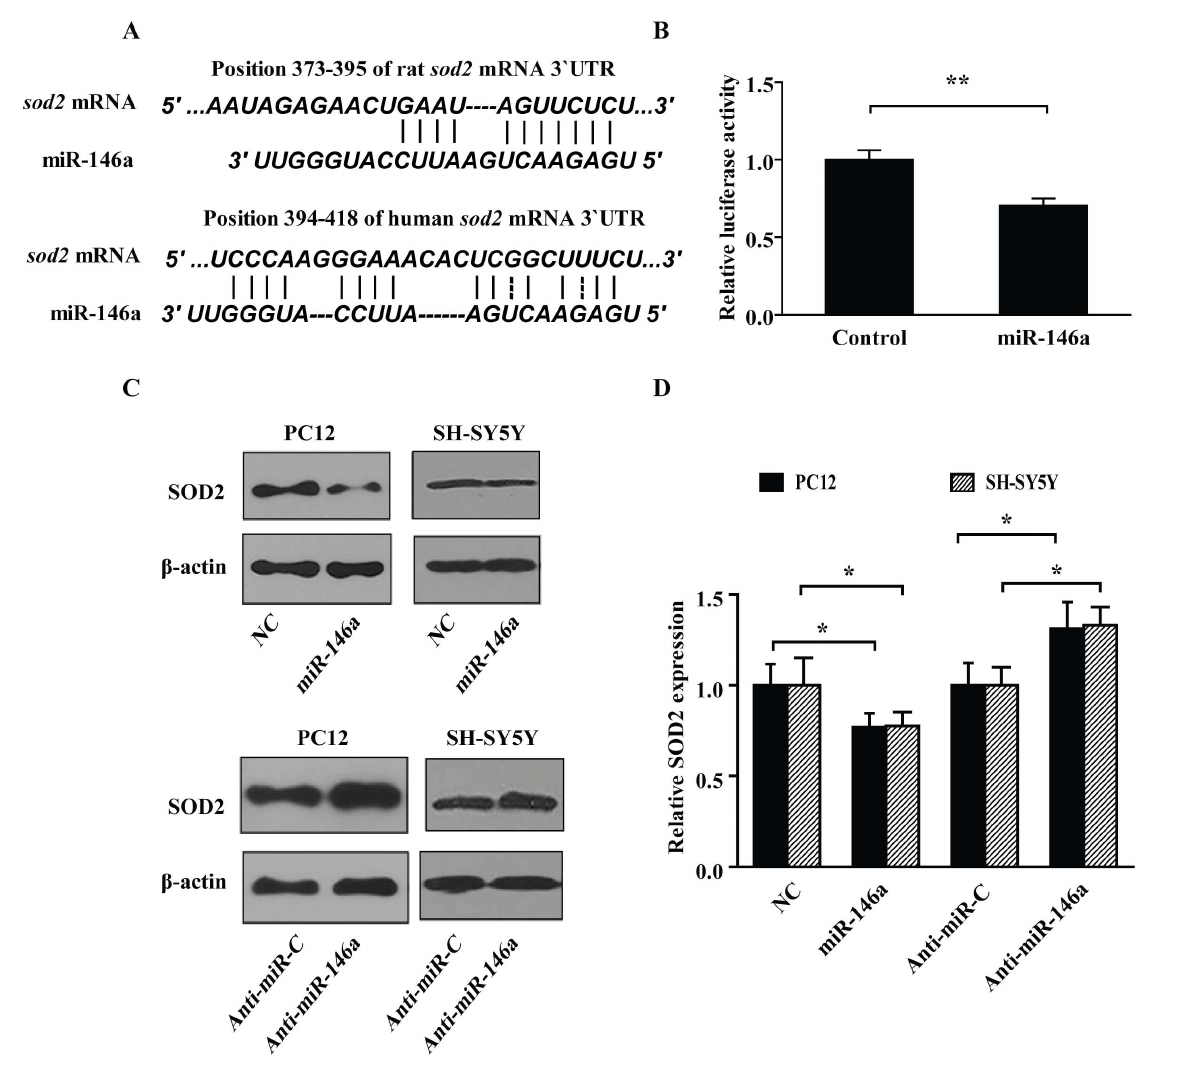
Figure 3. SOD2 was identified as a target of miR-146a in PC12 and SH-SY5Y cells. (A) Prediction of the interaction between sod2 mRNA 3 9 UTR and miR-146a. Sequence analysis showed that rat sod2 mRNA 3 9 UTR 388-394 position mated with the rat miR-146a 2-8th nucleotides. (B) miR- 146a down-regulated the luciferase activity of pGL3-Promoter-sod2-3 9 UTR. Dual luciferase reporter assay demonstrated that miR-146a mimics could down-regulate relative luciferase activity of pGL-sod2-3 9 UTR for 29.7%, compared with control group. Data are shown the mean 6 SD (n=6). ** P , 0.01, as compared with control. (C) miR-146a down-regulated the expression of SOD2 protein, while antisense-miR-146a reversely increased the amount of SOD2 protein. NC, non-targeting scrambled-miRNA control. Anti-miR-C, scrambled antisense miRNA control. Anti-miR-146a, antisense- miR-146a. (D) The relative amounts of SOD2 protein treated with miR-146a and antisense-miR-146a were presented by the intensity ratio between SOD2 and b - actin in each lane. Data are shown the mean 6 SD from 3 independent experiments, * P ,